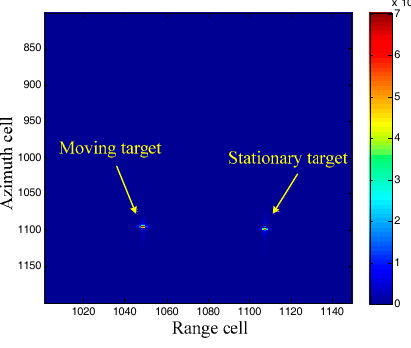
Figure 2. Imaging results by Doppler delay interferometry (DDI).